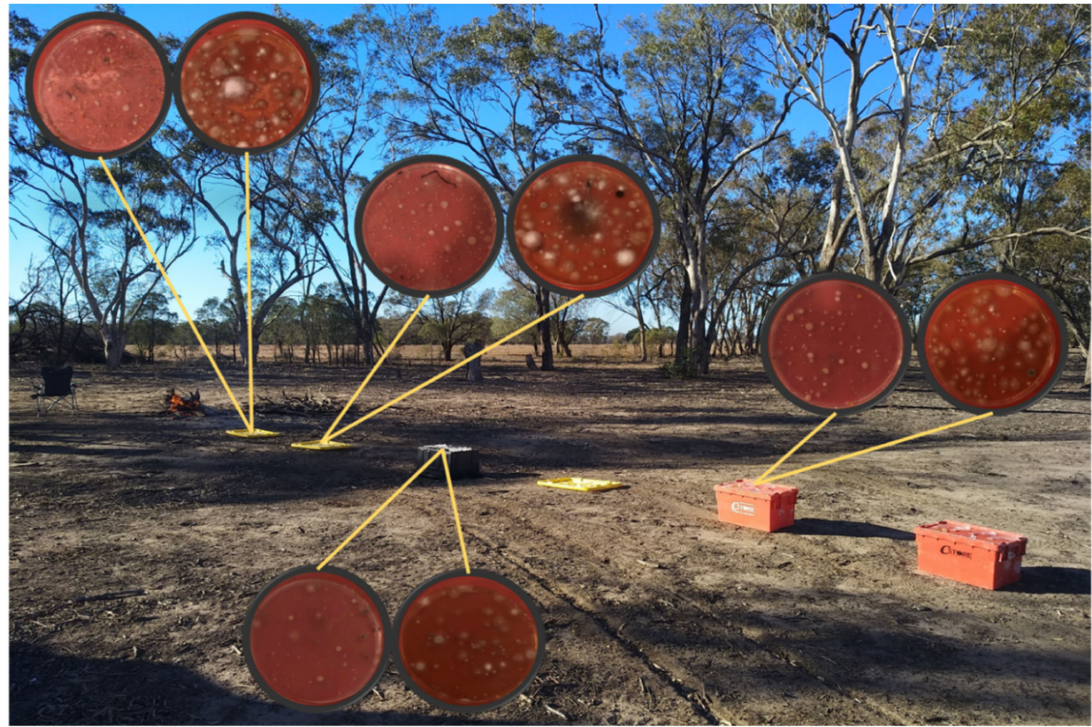
Figure 1. Positioning of Petri dishes in the Dirranbandi series of biomass combustion